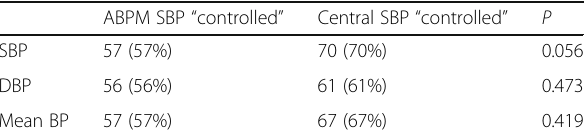
Table 2 Blood pressure variability